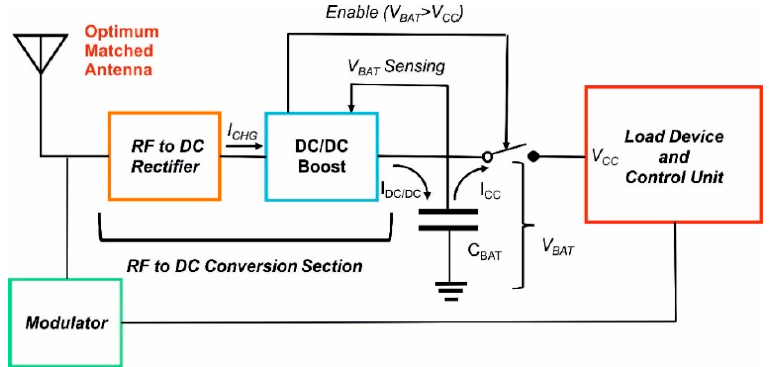
Figure 9. OBU full block diagram.